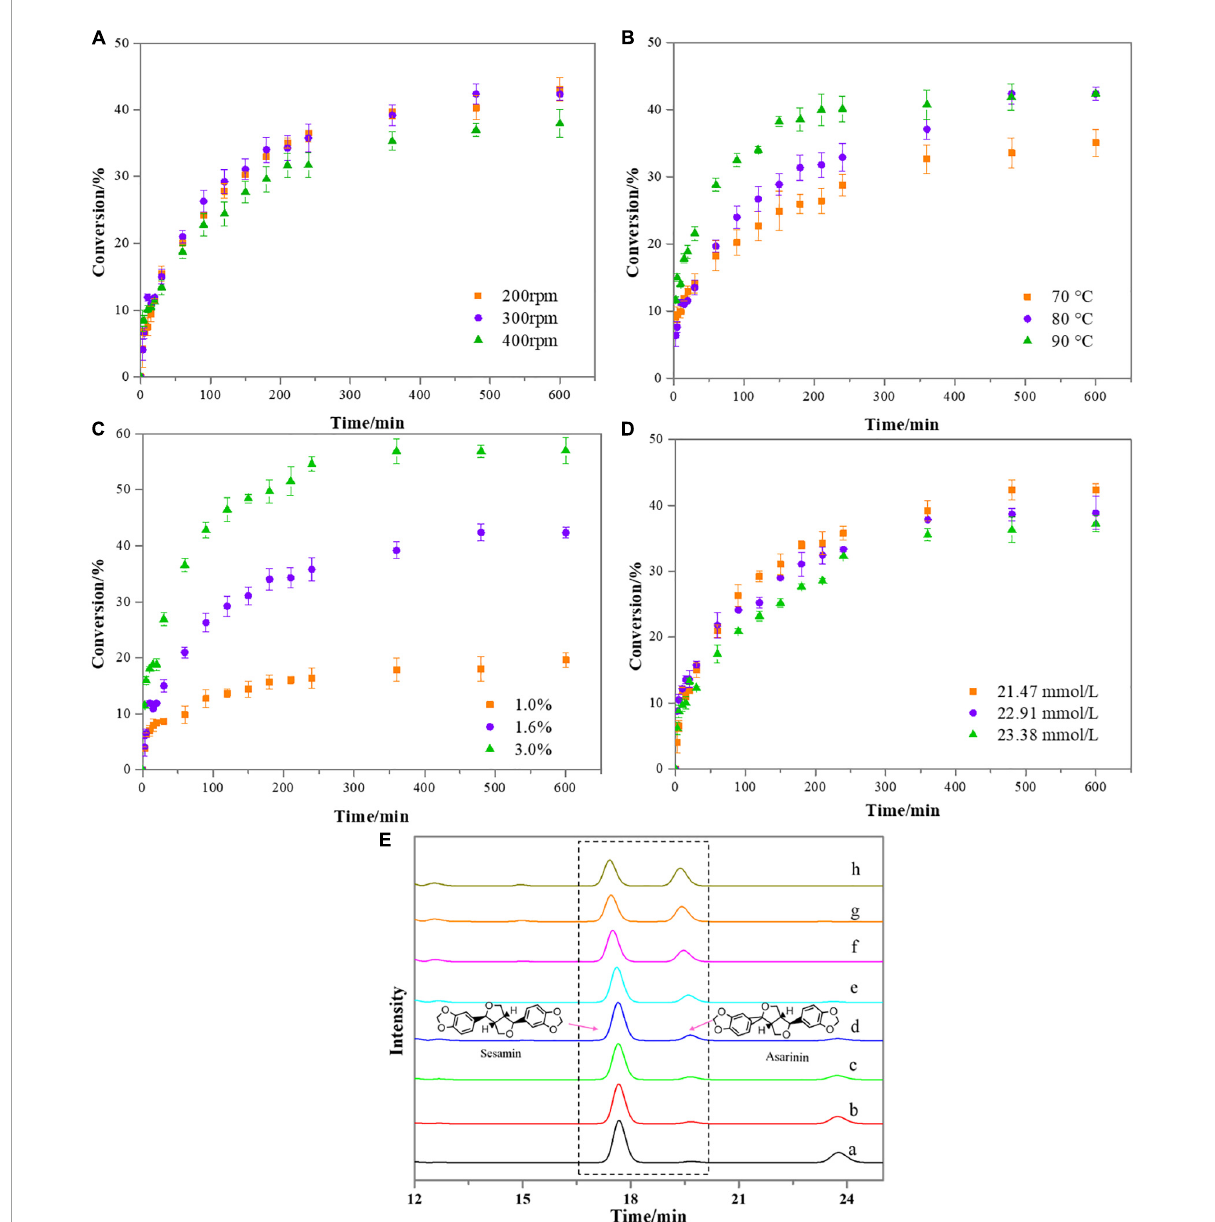
FIGURE3 Effect of reaction conditions on the kinetics of the sesamin conversion under the following conditions: (A) catalyst loading, 1.6%; sesame oil temperature, 80 ◦ C; reactant concentration, 21.47 mmol/L; (B) catalyst loading, 1.6%; rotation speed, 300 rpm; reactant concentration, 21.47 mmol/L; (C) sesame oil temperature, 80 ◦ C; rotation speed, 300 rpm; reactant concentration, 21.47 mmol/L. (D) Catalyst loading, 1.6%; sesame oil temperature, 80 ◦ C; rotation speed, 300 rpm. Bars represent standard deviation ( n = 3). (E) Variation in absorbance intensity of sesamin and asarinin in sesame oil samples at different reaction times under the following conditions: catalyst loading, 3.0%; sesame oil temperature, 80 ◦ C; rotation speed, 300 rpm; reactant concentration, 21.47 mmol/L (a, 3 min; b, 5 min; c, 10 min; d, 20 min; e, 30 min; f, 1.0 h; g, 2.0 h; h, 3.0